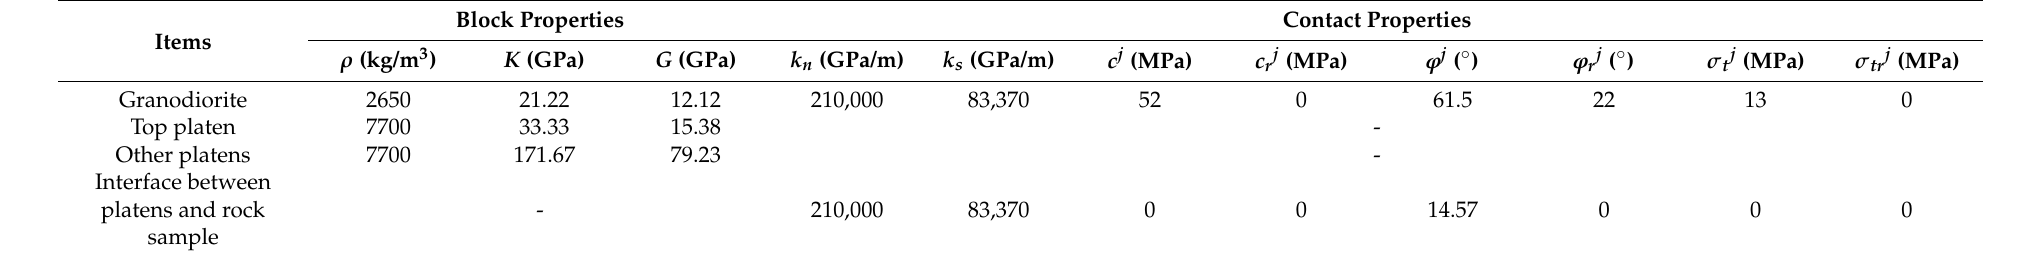
Table 1. Material properties used in the model